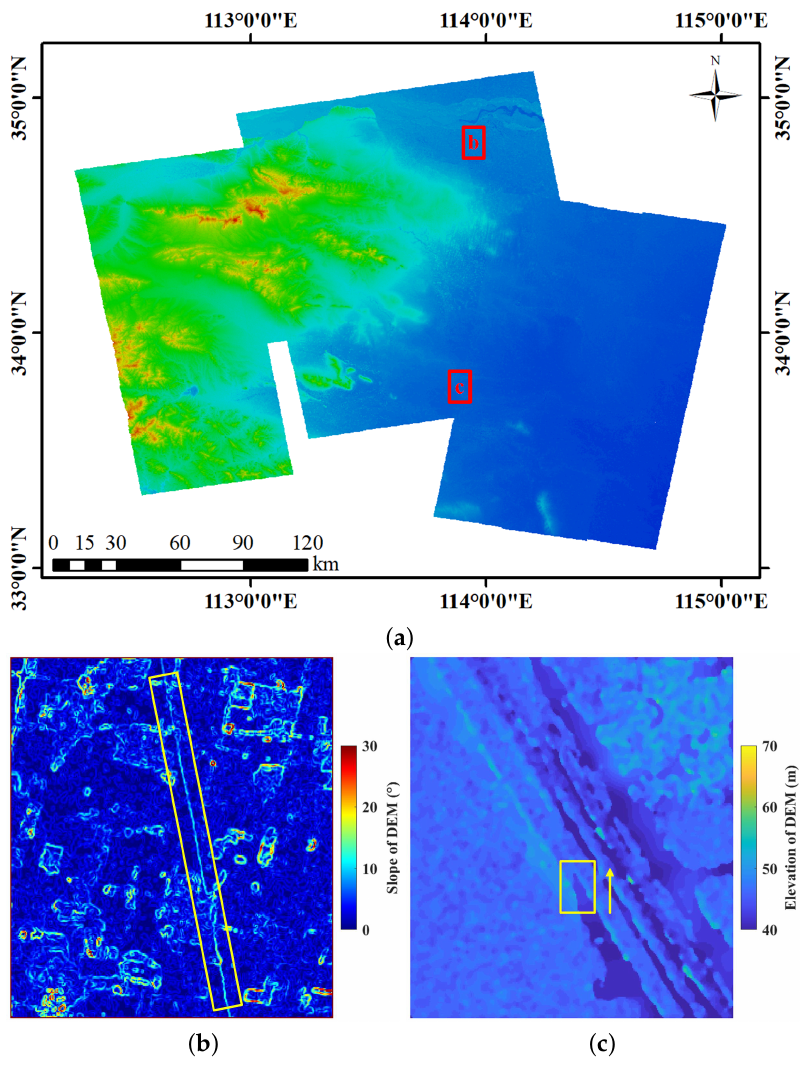
Figure 11. The mosaic rendering map of InSAR-generated DEMs before adjustment. ( b , c ) are the slope map and enlarged view of the corresponding marked areas in ( a ). The yellow boxes indicate the fracture areas. The yellow arrow indicates the direction of the plane